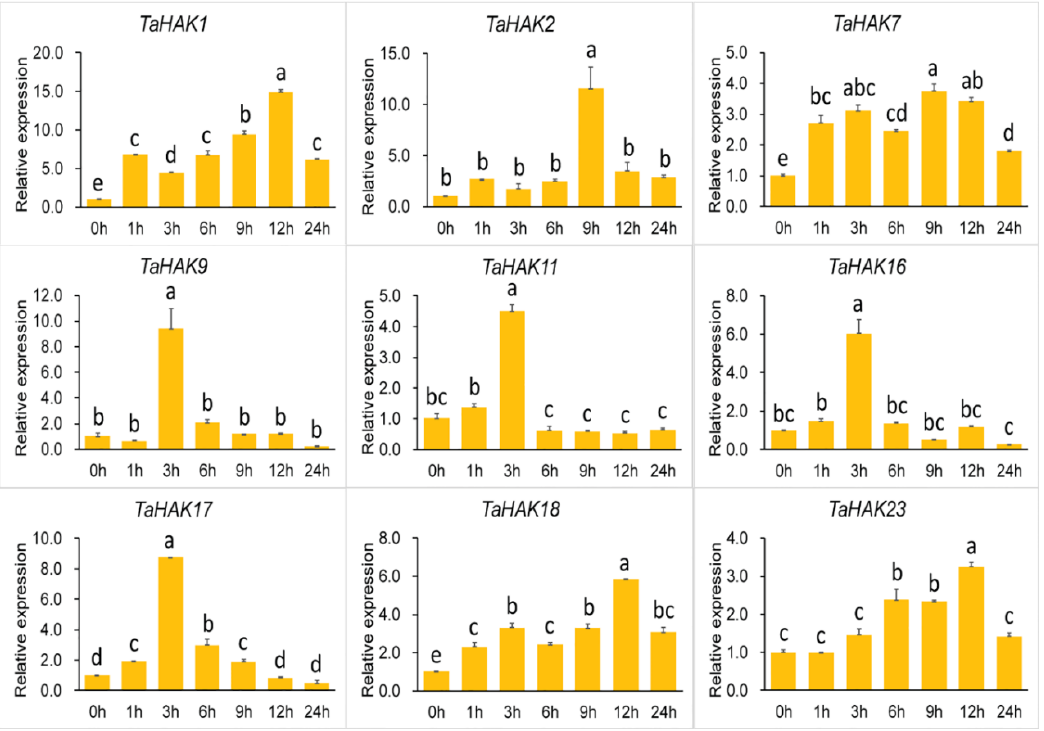
Figure 5. Expression of TaHAK genes in response to potassium deficiency stress (0.1 mM K + ). Expression of TaHAK genes was determined by qRT-PCR using total RNA isolated from wheat roots at different time points (0, 1, 3, 6, 9, 12 and 24 h) of the potassium deficiency stress. One-way ANOVA with Duncan’s multiple range test was conducted using SPSS version 20.0. Different letters on top of error bars indicate significant differences at p = 0.05 level. Error bars indicate the standard error (SE) of three replicates.